Question: Write the caption for this figure.
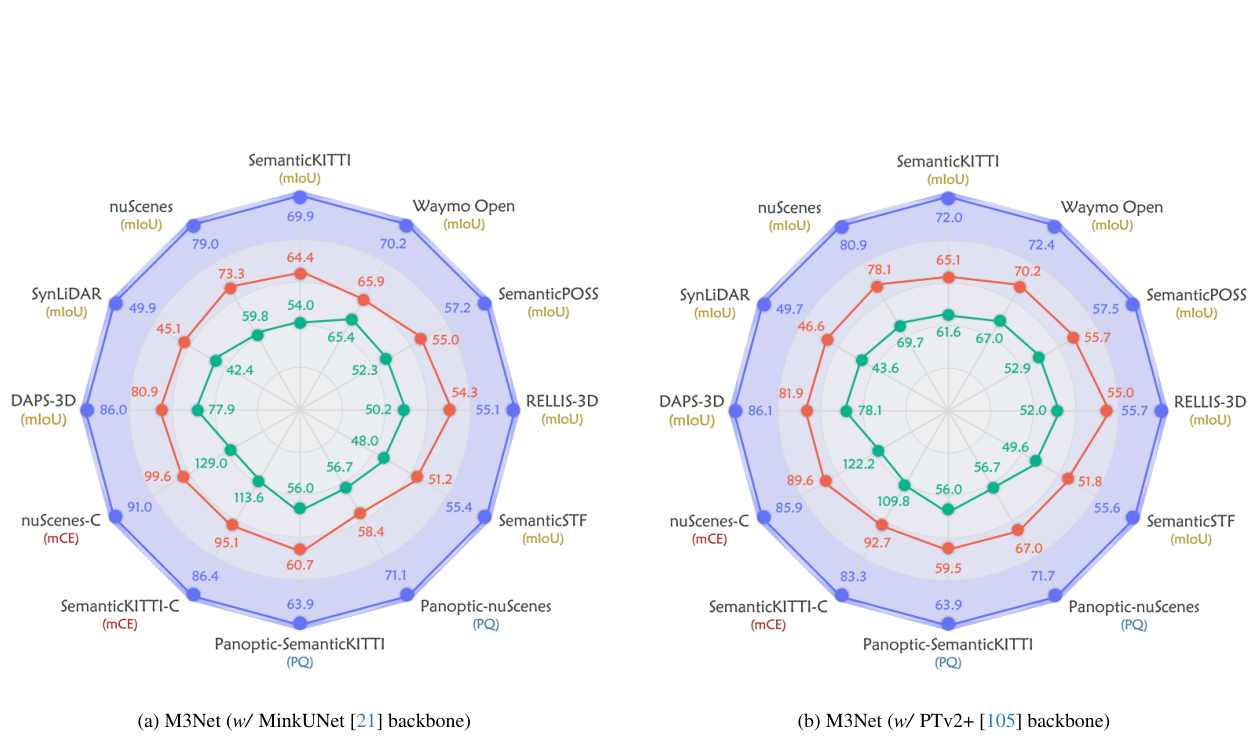
Answer: Performance comparisons among M3Net [•], Single-Dataset Training [•], and Na¨ıve Joint Training [•] across twelve LiDAR segmentation datasets. Subfigure (a): M3Net w/ a MinkUNet [21] backbone. Subfigure (b): M3Net w/ a PTv2+ [105] backbone. For better comparisons, the radius is normalized based on M3Net’s scores. The larger the area coverage, the higher the overall performance.